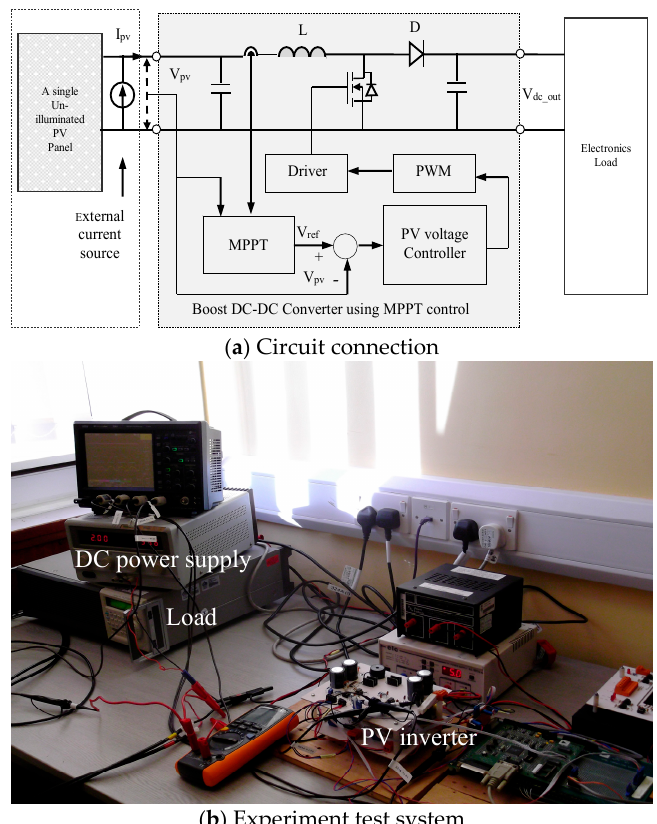
Figure 21. Measured I-V and P-V characteristics of the constructed PV source with three PV panels connected in series.